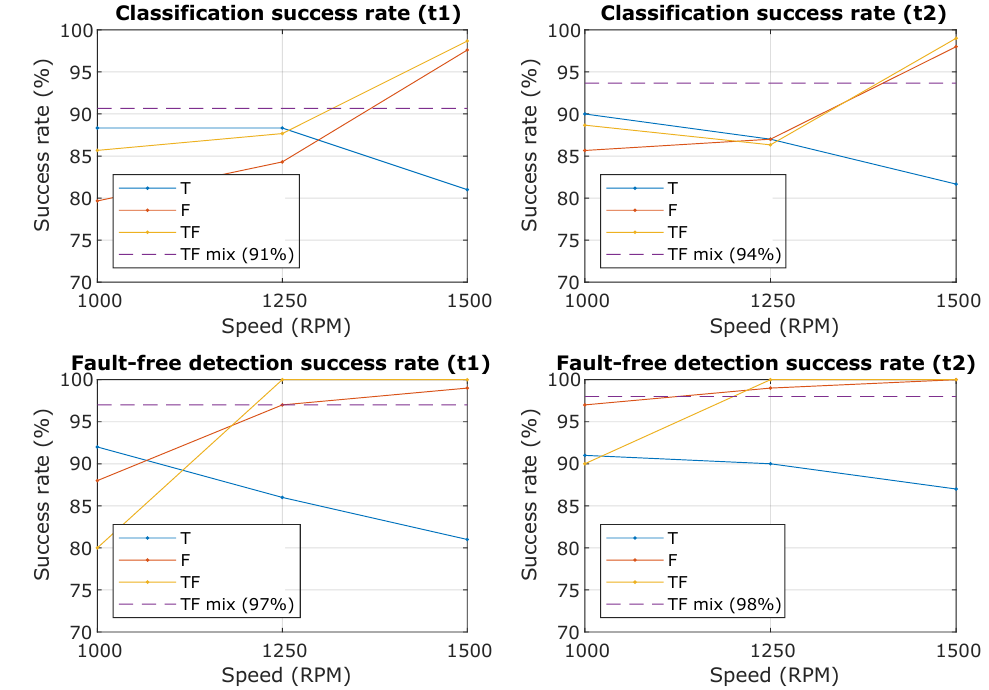
Figure 9. The resulting successes rate of the classification and the success rate of the prediction of the fault-free state. The waveforms from the graph are T—Time domain predictors only, F—Frequency domain predictor only, TF—All predictors together, TF mix—All predictors together for all RPM (from 1000 to 1500 with step